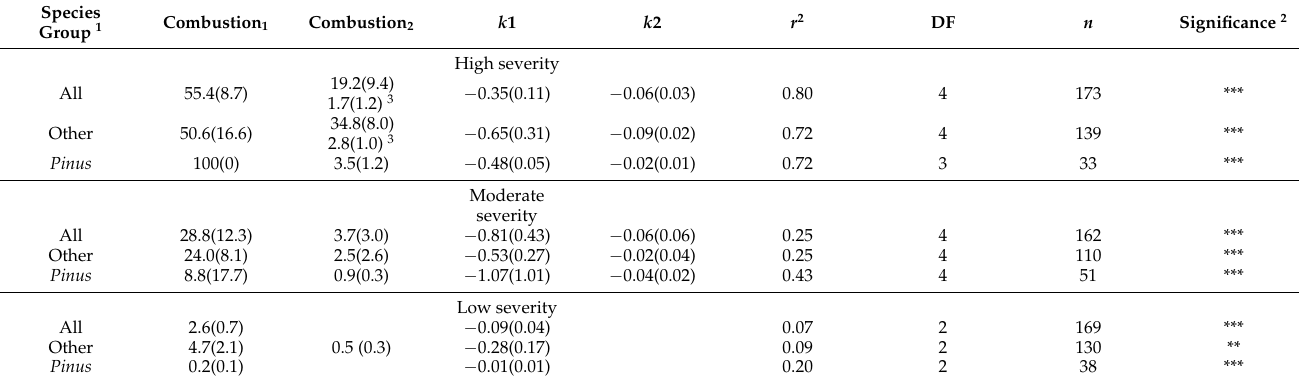
Table 2. Non-linear regressions predicting aboveground woody consumption in Creek and Rim Fires as a function of DBH for different fire severity classes and species